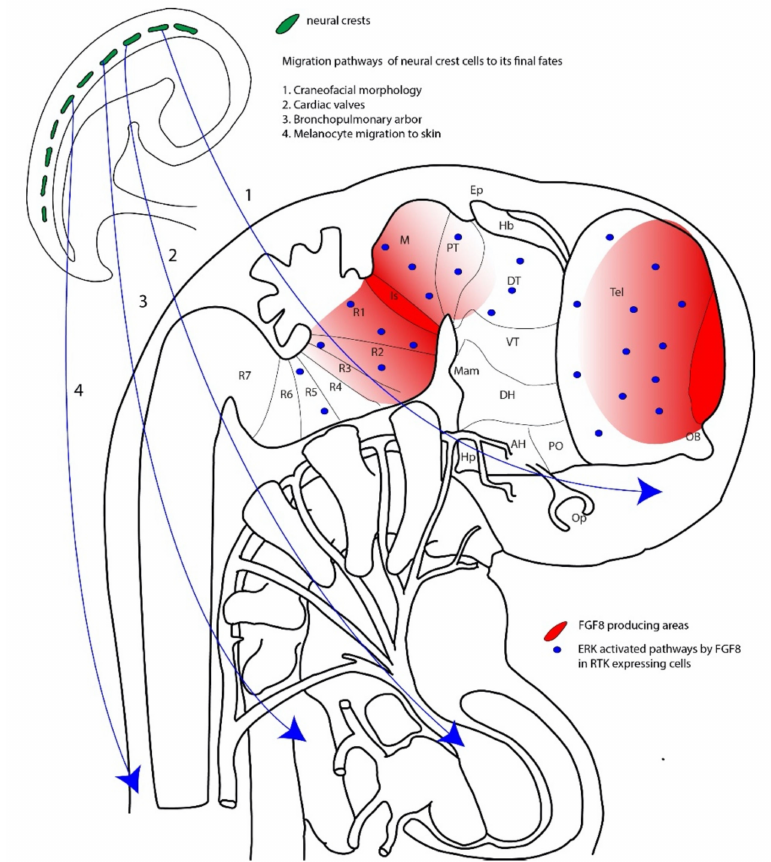
Figure 2. Role of MAPK / ERK signaling in embryonic development. Signals mediated by ERK promote the migration of neural crest cells to their final fates, so that disturbance of this signaling pathway may result in alterations of craniofacial morphology (1), cardiac valves (2), the bronchopulmonary system (3), and the melanocyte distribution in the skin (4). Additionally, the encephalic patterning depends, in part, on encephalic signals transmitted from the isthmus (Is) and the anterior ridge (AR), which create a gradient of FGF8 that can trigger pERK signaling in di ff erent segments of the neural